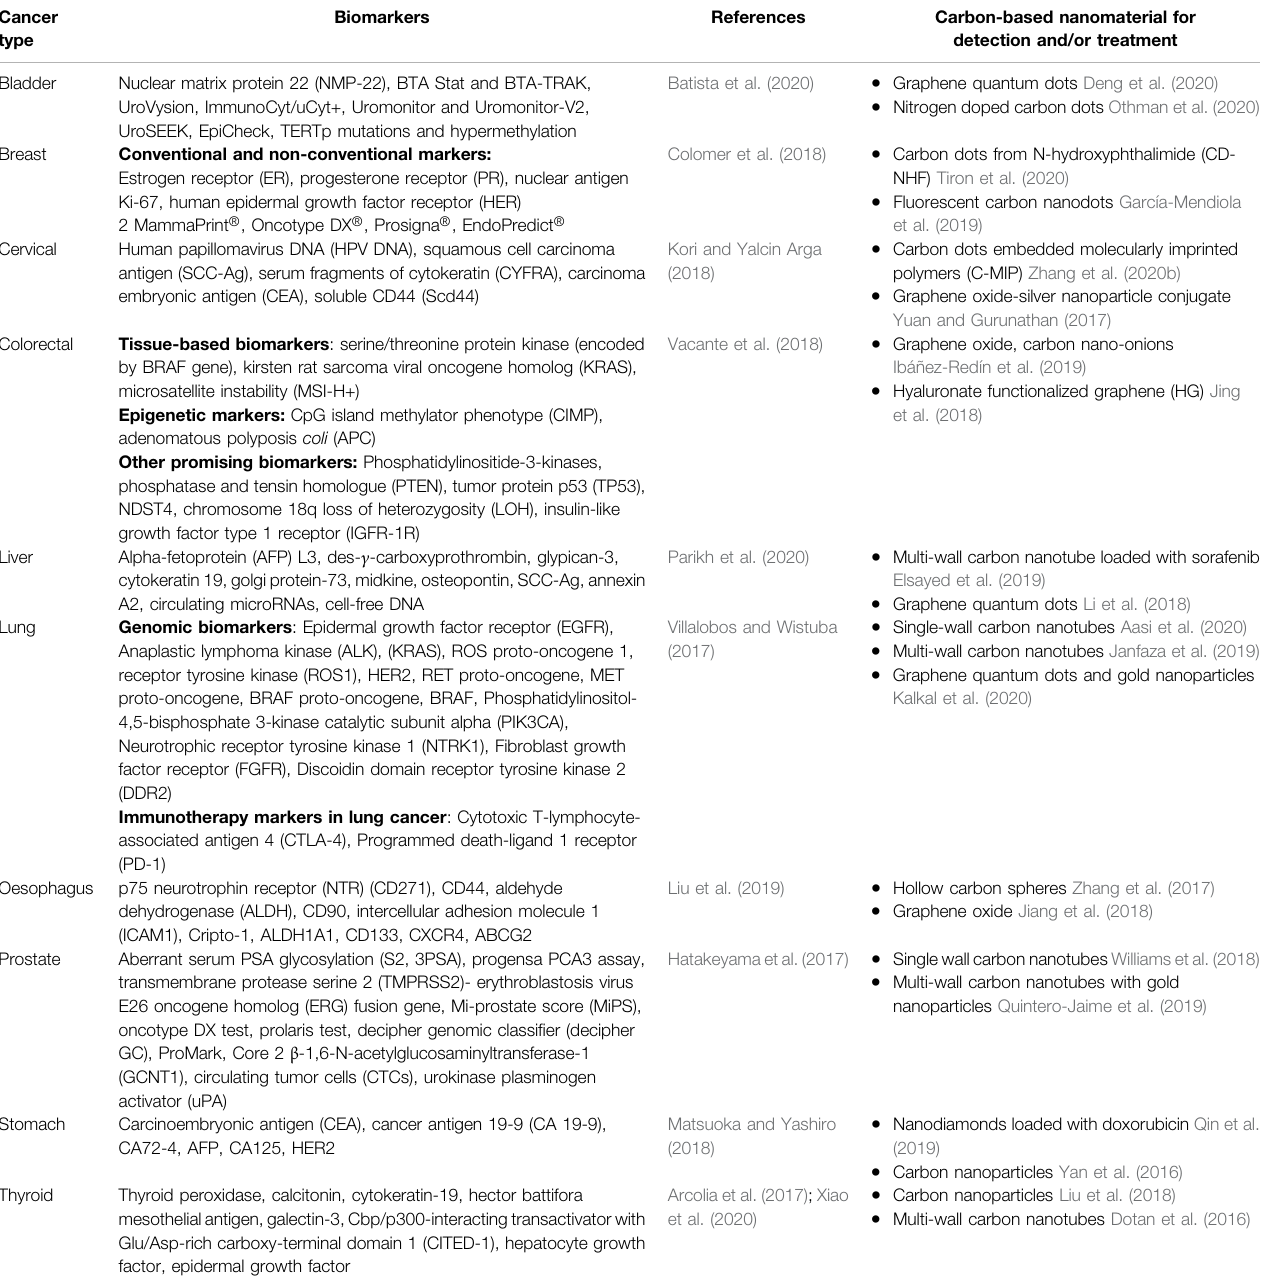
TABLE 2 | Chart of different biomarkers and carbon based nanomaterials for cancer diagnosis and treatment. Cancer type